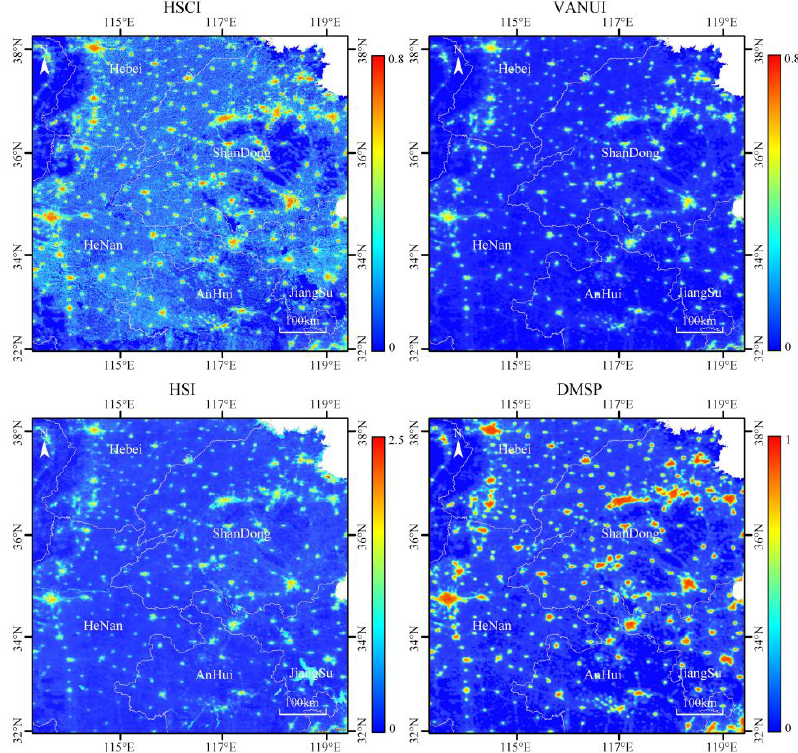
Figure 10. Spatial patterns of human settlements (most are villages and small townships) in mid-eastern China, which are delineated by HSCI, VANUI, HSI, and original DMSP (normalized) signals, respectively.